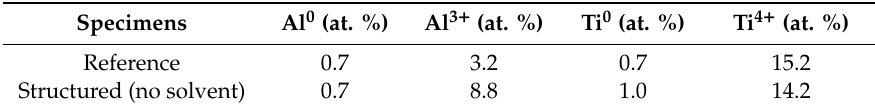
Table 3. Comparison of the relative amount of Al 0 , Al 3 + and Ti 0 , Ti 4 + on the surface of reference and structured surface without cleaning after 1 day of storage.